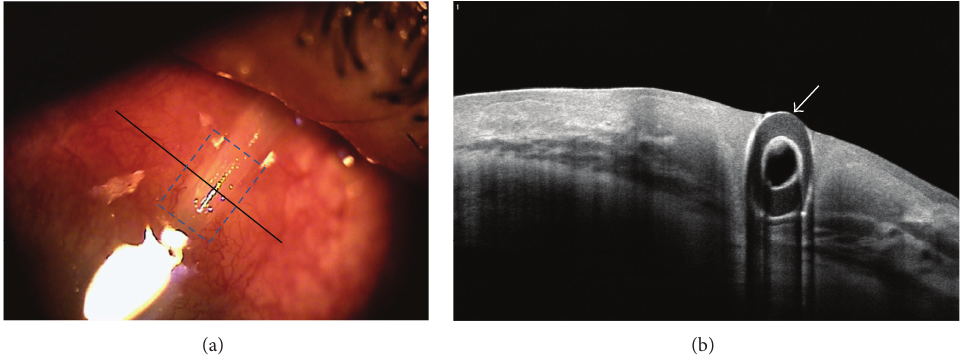
Figure 13: Tube erosion of glaucoma drainage device. Anterior segment optical coherence tomography image. Slit lamp examination revealed an extruded tube of glaucoma drainage device (GDD, Ahmed valve) with melting of scleral patch and conjunctival erosion. (a) Anterior segment optical coherence tomography (OCT) also displayed the GDD tube extrusion and loss of overlying conjunctiva